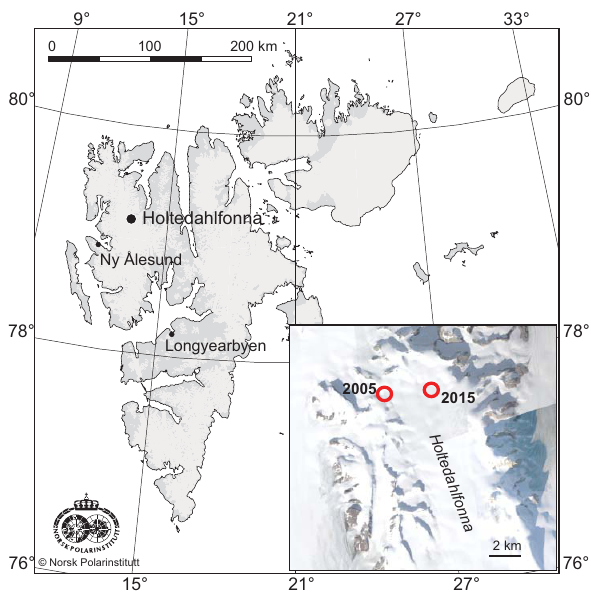
Figure 1. Map of Svalbard and the location of study sites on the Holtedahlfonna glacier. The inset presents an aerial satellite image of the Holtedahlfonna glacier in summer. The 300-year ice (2005) and firn (2015) core study sites are indicated by red